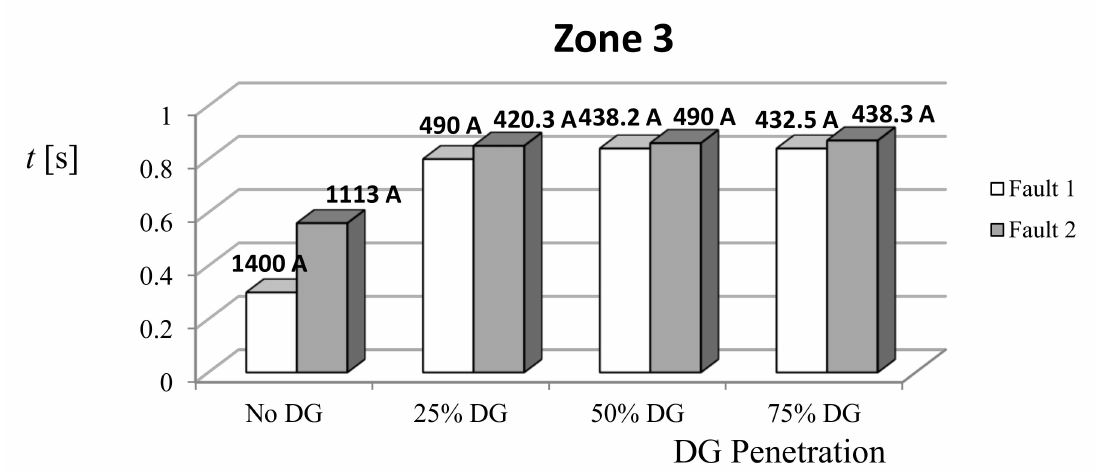
Figure 13. Triggering time, t , of the main feeder protection relay R632 in Protection Zone 3 (see Figures 2 and 10) for fault F1 upstream the DG and fault F2 downstream the DG, in relation to DG power supply. The currents detected by the relay when triggering were added to the graph in each